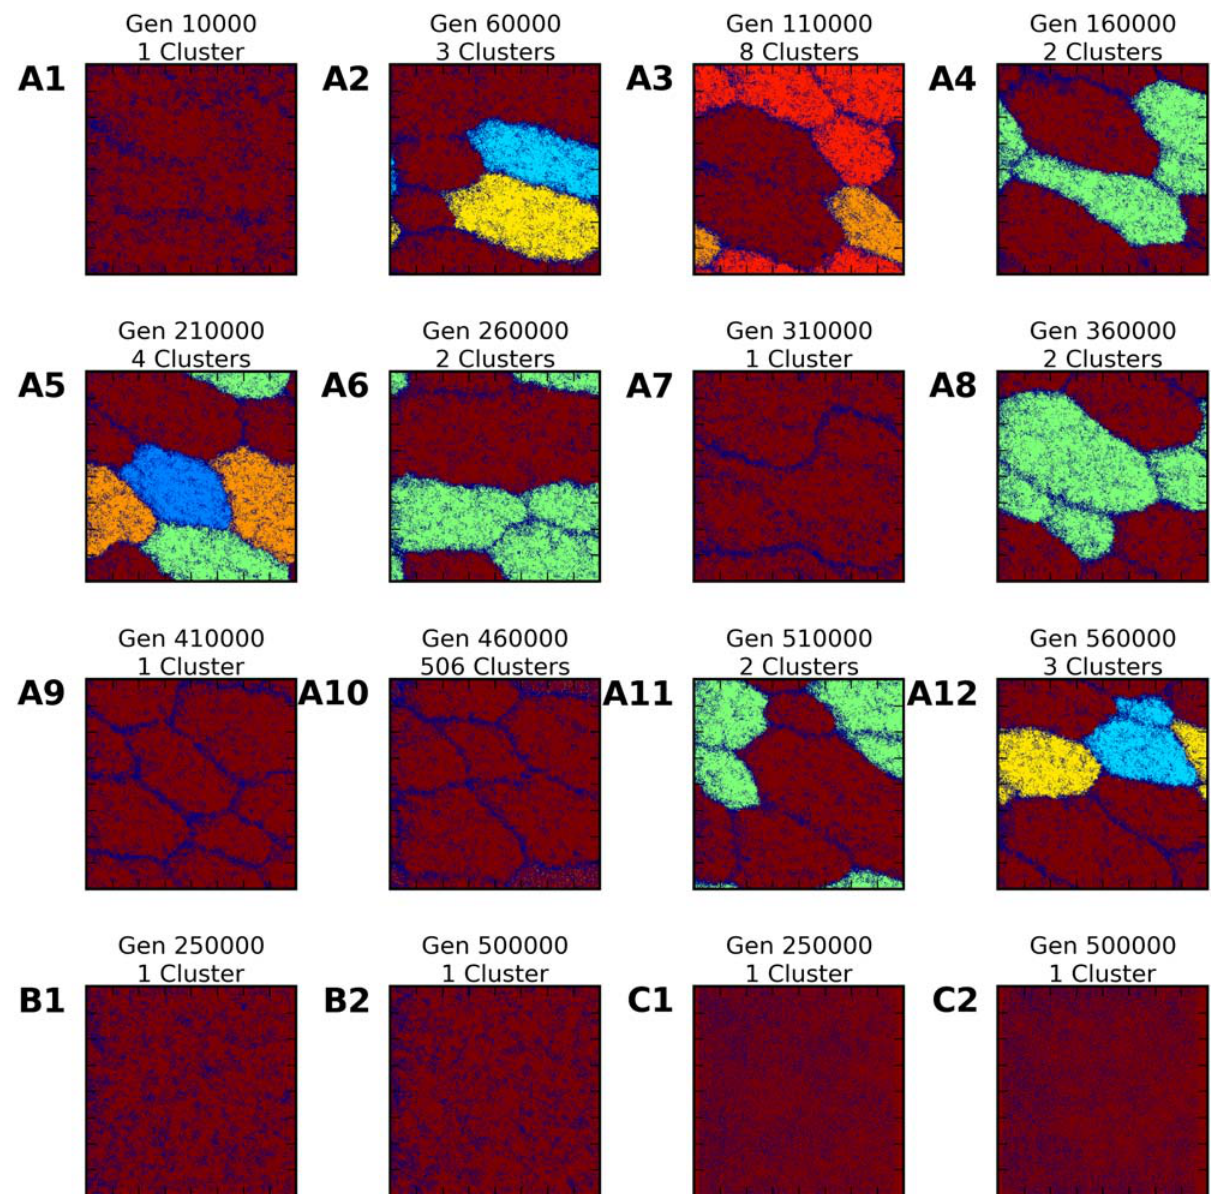
Figure 5. False-Color Depiction of Genetic Clustering on the World Grid. Dark blue represents unoccupied cells or cells from which genomes were sampled that were not connected to any cluster. Each other color represents a set of gametes with genome sequences that are identical at more than 40% of their nucleotide sites, created according to the algorithm described in the text. Gametes colored differently have genomes that are identical at 40% or less of their nucleotide sites. Using this threshold in combination with h =0.6 helps identify different species with different colors. Note that (1) colors were assigned anew in each plot, so particular colors do not track the same lineage across plots, (2) the clustering algorithm is probabilistic because it is computationally expensive to compare every individual with every other individual for determination of genetic difference, and (3) some clusters are too small to discern in these plots. Plots (A1) through (A12) depict snapshots of the clustering state at 12 different generations during the simulation run with low movement distance of d =1.5 and outbreeding depression threshold h =0.6, the same simulation shown in the (A) portion of earlier figures. Also following previous figures, plots (B1) and (B2) were generated under a low movement distance of d =1.5 without outbreeding depression. This model shows no evidence of clustering at the difference threshold of 0.6 for two representative generations (250,000 and 500,000), nor for any other generations examined (not shown here). The (C) plots, for a simulation run with a larger movement distance of d =5 and outbreeding depression enabled at a threshold of h =0.6, presents a similar lack of